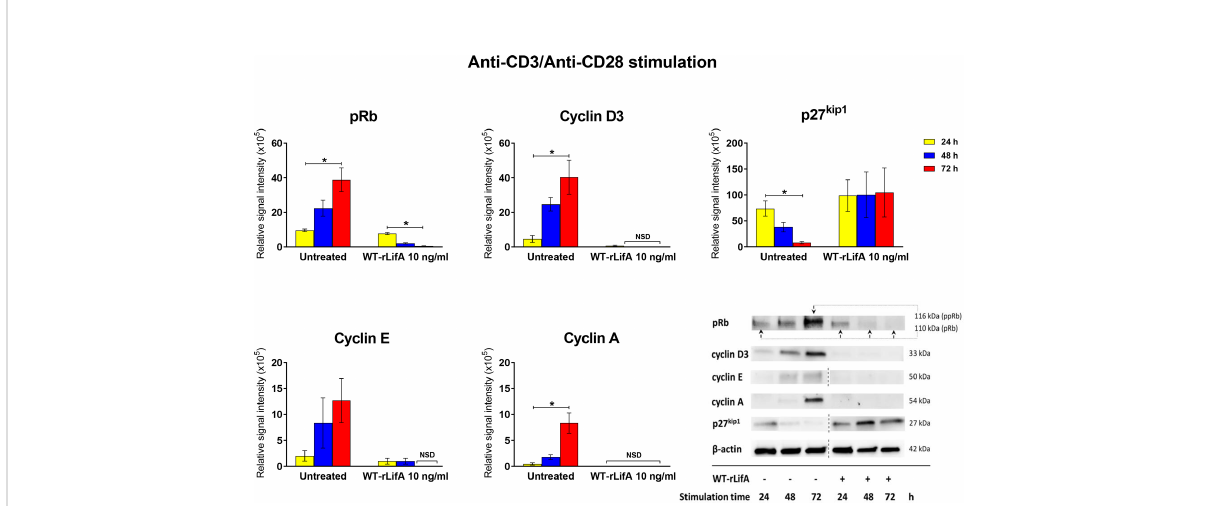
FIGURE 11 Lymphostatin inhibits expression of cell cyclins and pRb while causing accumulation of the cell cycle inhibitor p27 kip1 . Bar graphs showing densitometric analysis of cell cycle proteins (pRb, p27 kip1 , cyclins D3, E, and A) detected by Western blot in anti-CD3/anti-CD28-stimulated T cells treated with 10 ng/ml of WT-rLifA compared to untreated cells (cells with mitogen; no tested protein) at varied stimulation time. Data are derived from analysis of cells from 3 healthy donors. Data are expressed as mean ± S.E.M. * p < 0.05 using Kruskal-Wallis test followed by Dunn ’ s test. NSD means no signal detected. Representative immunoblot image showing the abundance of cell cycle proteins in anti-CD3/anti-CD28- stimulated T cells treated with 10 ng/ml of WT-rLifA compared to untreated cells at varied stimulation time. Data are representative of cells from one donor. The dotted line indicates that some non-relevant lanes were cropped to aid